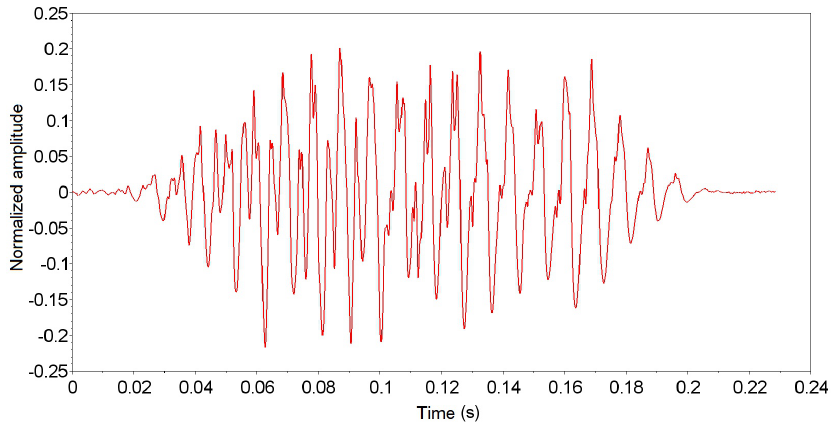
Figure 15. Anastrepha fraterculus passing event signal classified in the standard group.